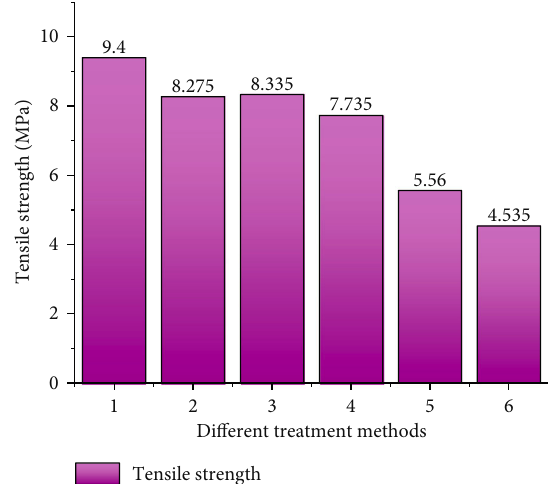
Figure 6: The statistical chart of the tensile strength of rock samples after various